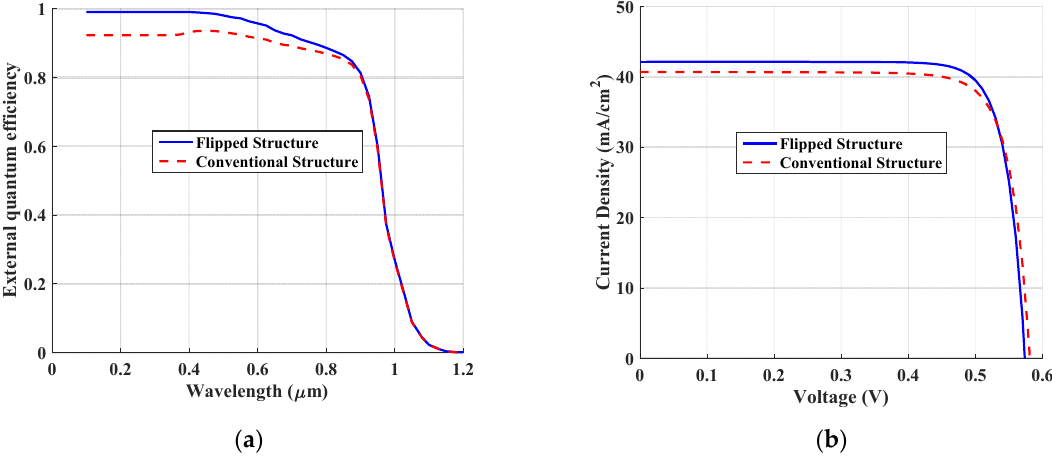
Figure 2. The flipped structure using SILVACO Athena process simulator: ( a ) cross-sectional view for the whole cell showing the absolute net doping contours in cm − 3 , ( b ) a close view near the emitter region, ( c ) vertical cutline (perpendicular to the upper surface) showing the doping profile of the vertical pn junction and ( d ) lateral cutline showing the doping profile of right lateral pn junction.